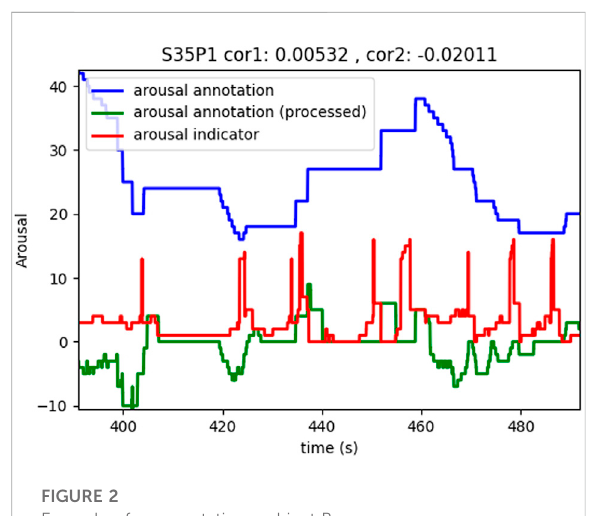
FIGURE 2 Example of an annotation – subject